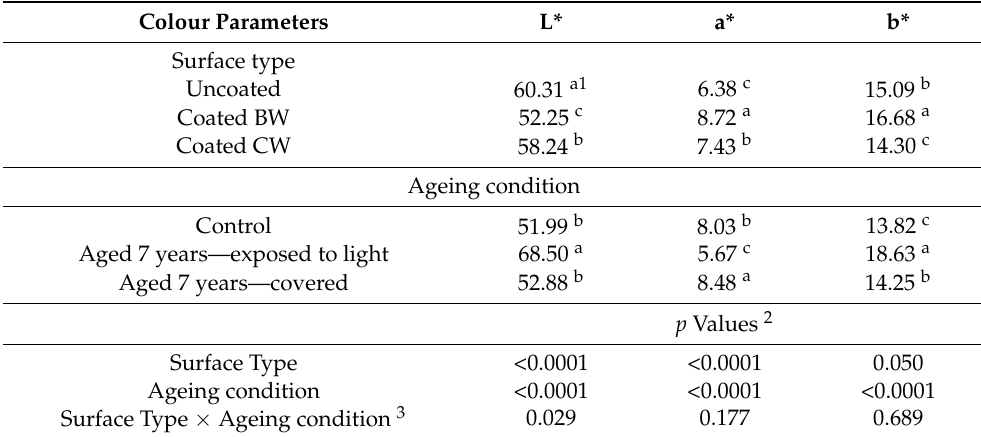
Table 4. Results of the two-way ANOVA statistical analysis of colour data for the uncoated and wax coated (BW, CW) samples of European walnut, before and after 7 years of indoor